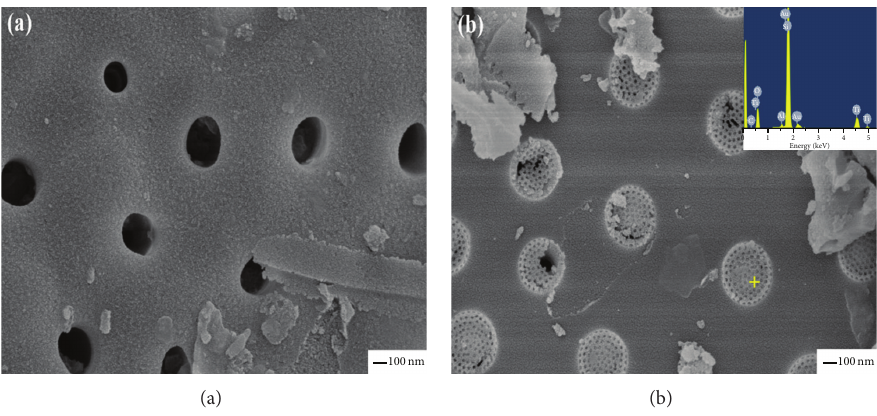
Figure 1: The microstructure of diatomite and TiO 2 /diatomite composite. Table 1: Chemical analyses of diatomite and TiO